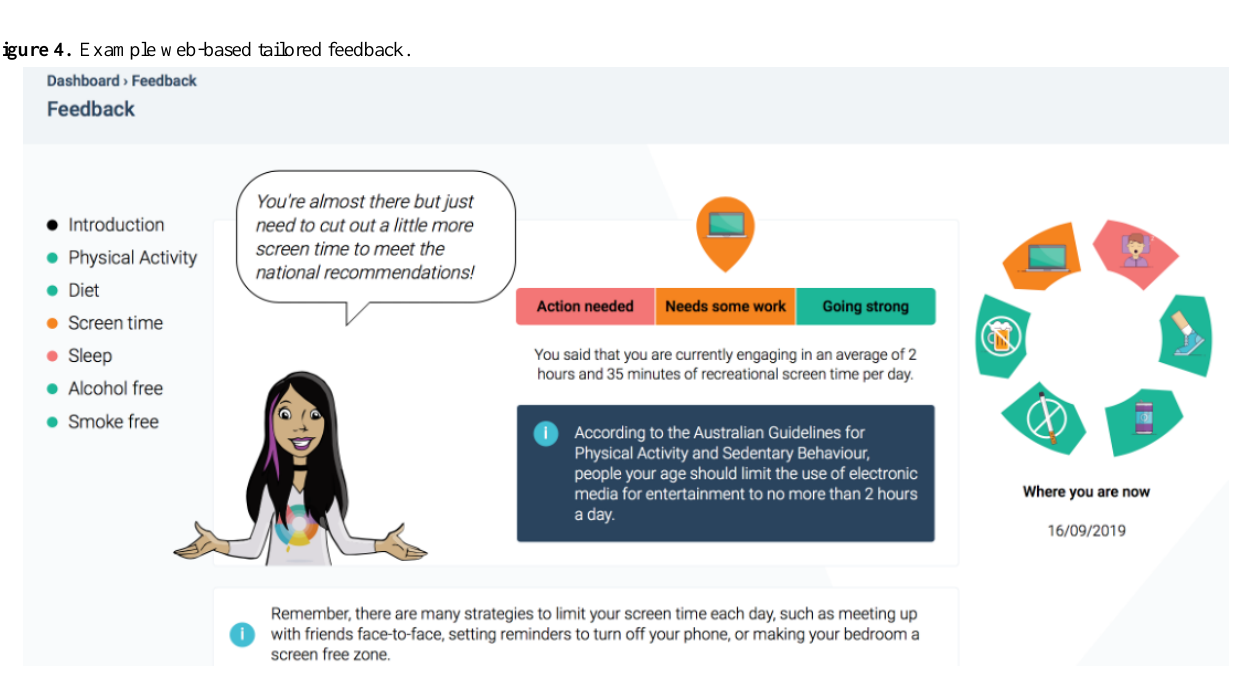
Figure 4. Example web-based tailored